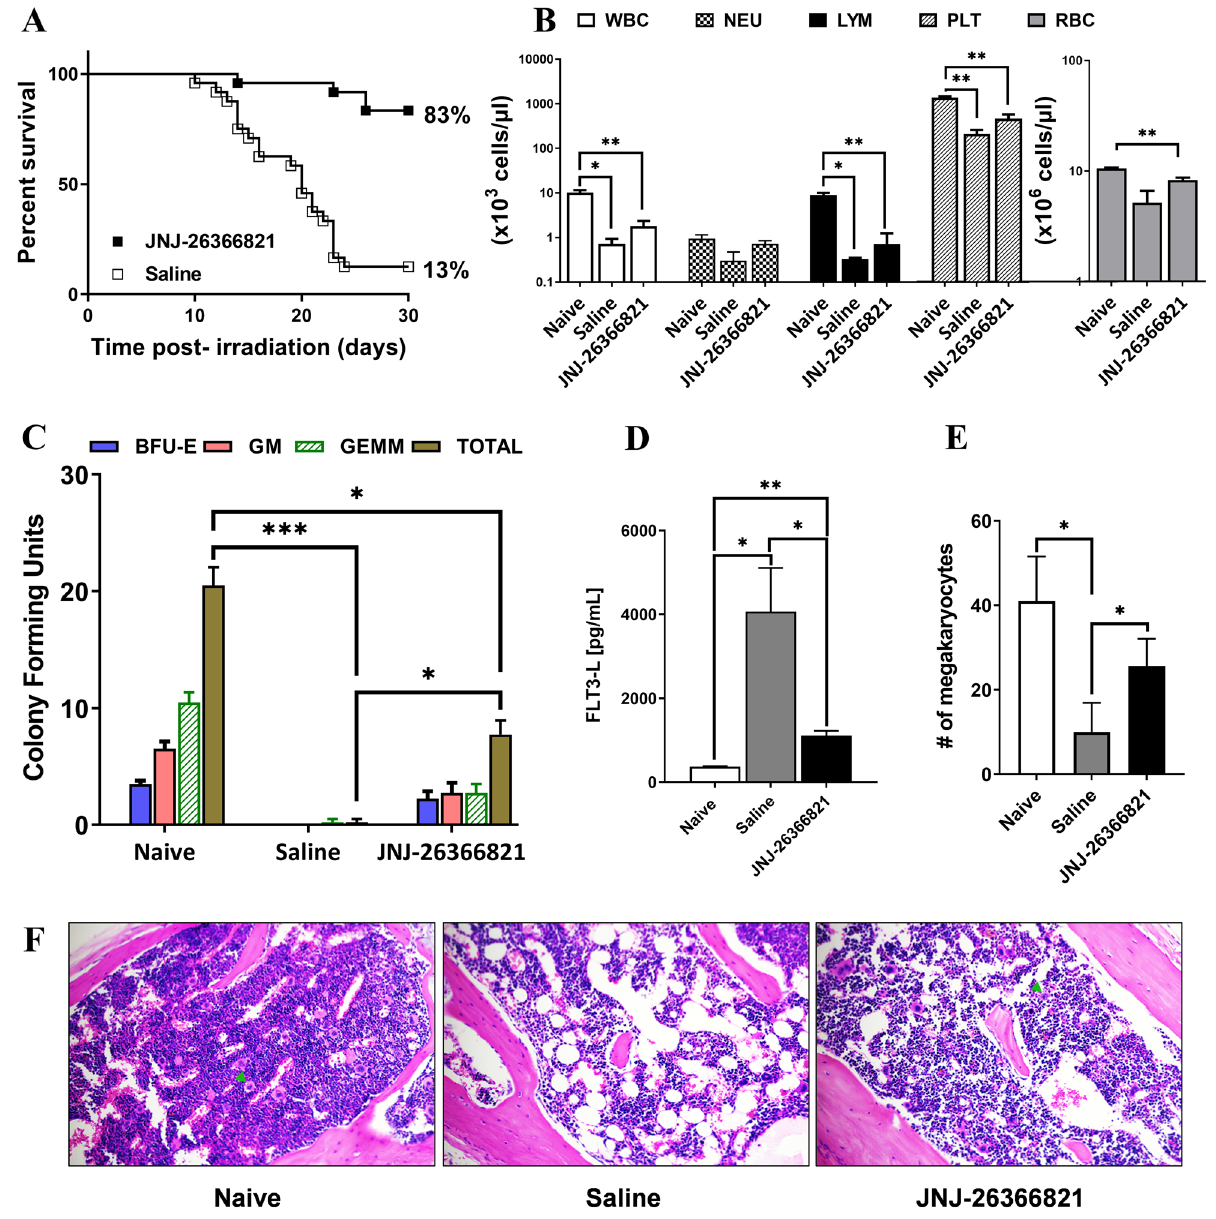
Figure 4. ( A ) Survival in C57BL/6 male mice following 8.0 Gy total body irradiation (TBI). A single dose of JNJ-26366821 at 1 mg/kg ( ■ ) or saline as a vehicle ( □ ) was administered 24 h post-TBI to C57BL/6 male mice. Kaplan–Meier survival curves were plotted using GraphPad software; n = 24 mice per group and trend in survival is compared between vehicle and drug-treated groups (Log-rank test p < 0.0001). Percent survival on day 30 post-TBI is shown at the end of each curve. ( B – E ) The non-irradiated naïve group was compared with the irradiated groups (saline and JNJ-26366821). ( B ) Peripheral blood cell counts on day 30 post-TBI (8 Gy). White blood cells (WBC), neutrophils (NEU), lymphocytes (LYM), red blood cells (RBC) and platelets (PLT) were measured. ( C ) Recovery of femoral bone marrow was estimated by Colony forming Unit assay. On day 30 post-TBI (8 Gy), the JNJ-26366821 group had significant recovery ( p = 0.01) compared to saline group. ( D ) Serum levels of FLT3-L on day 30 post-TBI (8 Gy) were measured by ELISA showing recovery by JNJ-26366821 treatment. Data represented are mean ± standard error of the mean (SEM) for n = 3 mice. ( E ) Recovery of cellularity of sternal bone marrow was determined on day 30 post-TBI (8 Gy). The number of megakaryocytes were counted in all three groups. The JNJ-26366821 group showed significant recovery ( p < 0.05) compared to saline group. Significant difference ( p < 0.001–0.05) by t-test is indicated with an asterisk (*). ( F ) Representative sternal bone marrow sections are shown for naïve, irradiated saline and JNJ-26366821 groups. Green arrows indicate megakaryocytes. Figures were plotted using GraphPad Prism 9 software V9.0.2; www. graph pad.